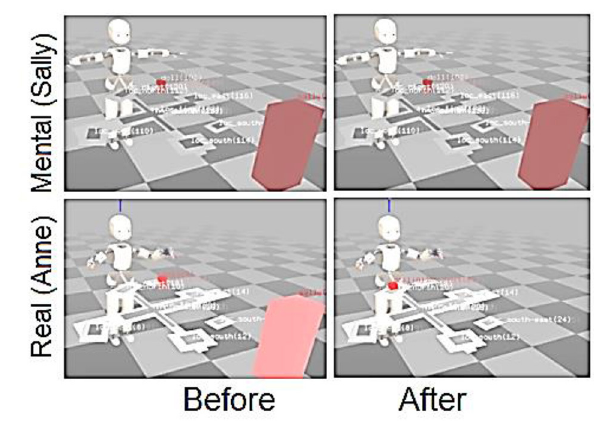
FIGURE 10 | Contents of mentalOPC and realOPC in the Sally–Anne task. OPC stands for Objects Properties Collector and is a form of working memory. It stores everything the robot knows at the current time. In the “Before” column is represented the contents of both OPCs when the toy (the small red cube) has been placed at the first location (to the robot’s left). The mentalOPC is the system’s representation of what it and Sally have seen. In the “After” column, the Actual situation represents the contents of the realOPC after the toy has been moved (in front of the robot). In that same column the mentalOPC represents what Sally observed before she left. If this is maintained in memory, then it will persist after the world has been changed, and it can be used to mentalize about where Sally would look for the toy. From Pointeau et al. (2013).